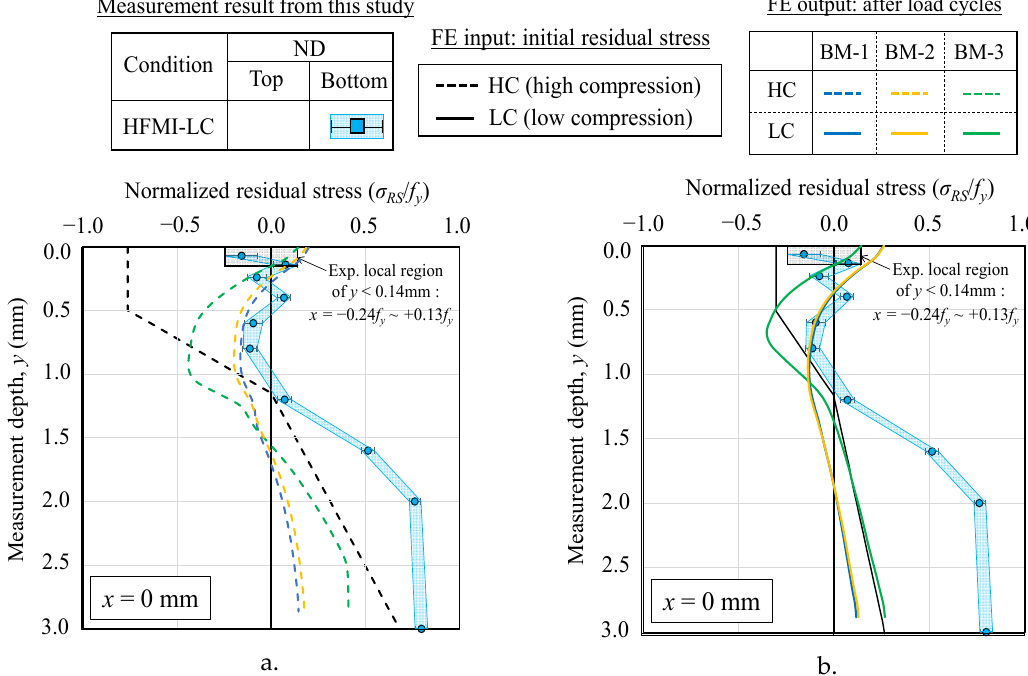
Figure 12. Numerical and experimental comparison of the residual stress distributions after the stress relaxation at x = 0 mm. ( a ) HC case as FE input; ( b ) LC case as FE input.